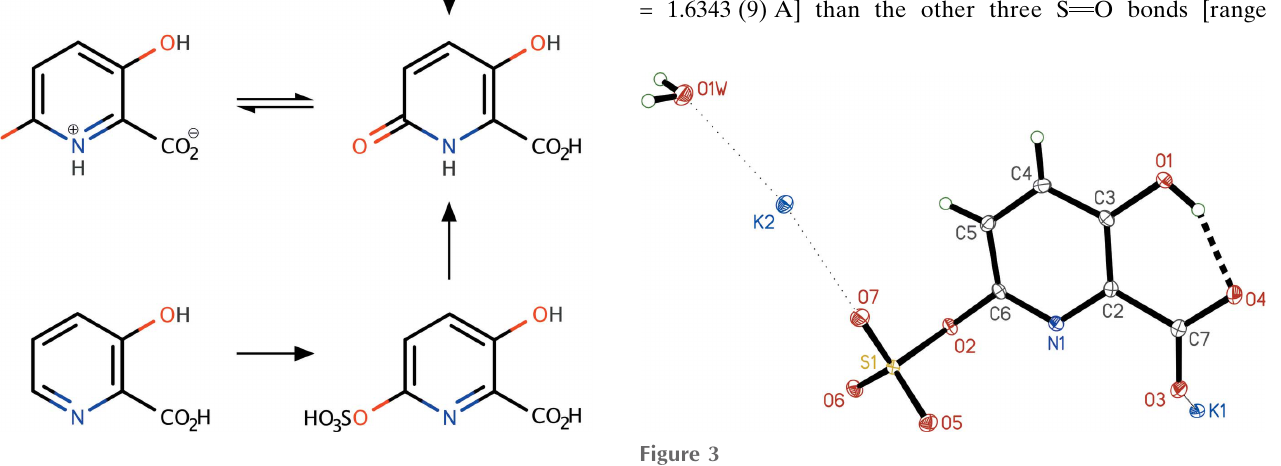
Figure 1 Two synthetic routes to 3,6-dihydroxypicolinic acid ( II ), showing tautomerism of the